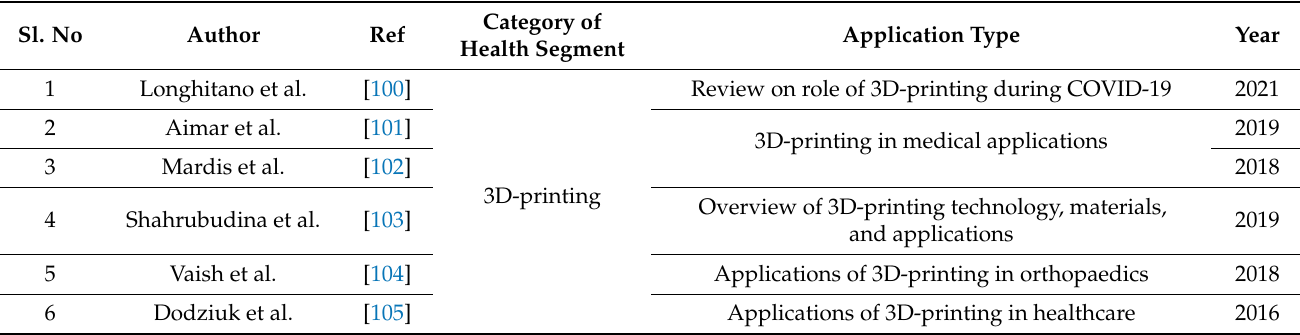
Table 4. Review signifying applicability of 3D-printing in various healthcare